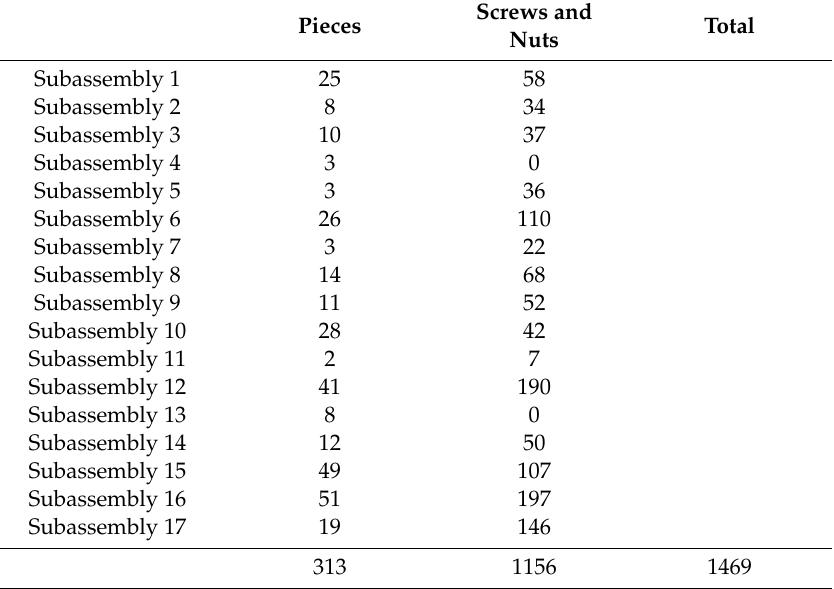
Table 2. Frequency analysis of pieces that integrate the SO / PHI subassemblies.